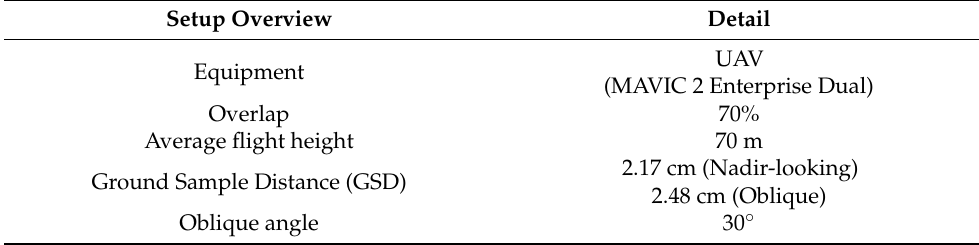
Table 1. Specification of the visible image sensor.